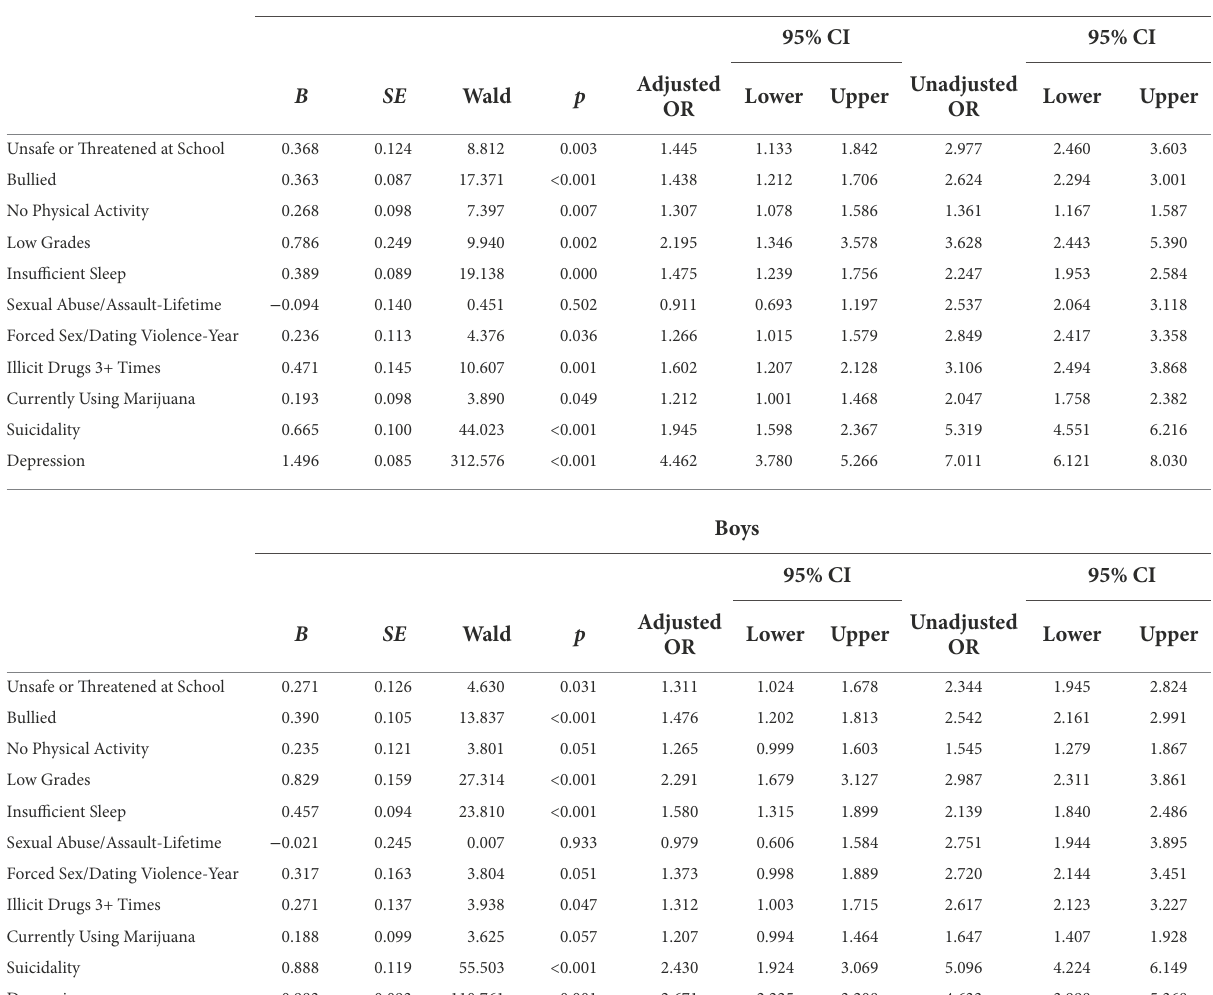
TABLE 4 Logistic regressions predicting perceived cognitive impairment stratified by